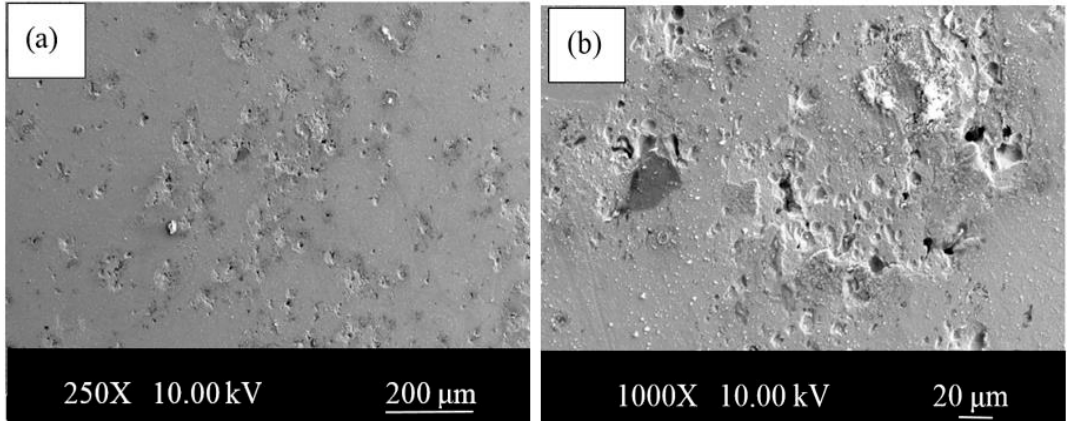
Figure 8. SEM images of the alloy 2-NbV-0Ni after corrosion ( a ) low and ( b ) high magnification.